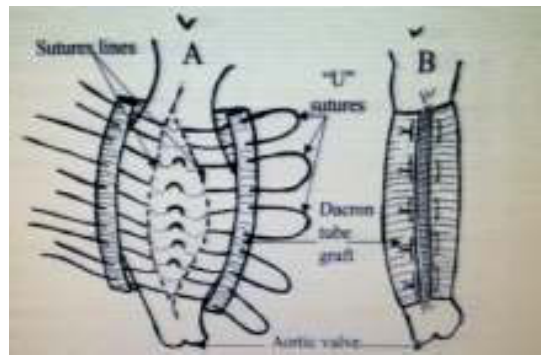
1: Schematic View of Reduction Aortoplasty with Mesh.